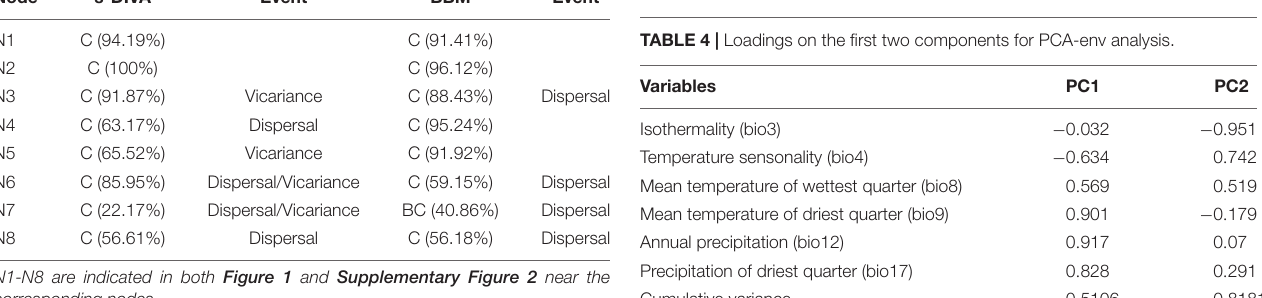
geographic units and optimal area reconstruction at each major node are summarized in Supplementary Figure 2 . In RASP, both s-DIVA and BBM favored ancestral distributions of most of the major clades of Artemisiinae (N1-N8) in Central Asia (region C; > 50%) ( Table 3 and Supplementary Figure 2 ). Subsequent vicariance between Central Asia and other regions of Asia was reconstructed by s-DIVA for node N3 and N5, and dispersal from Central Asia to the QTP and eastern parts of Asia was reconstructed for nodes N4, N6-N8 and Chrysanthemum -group